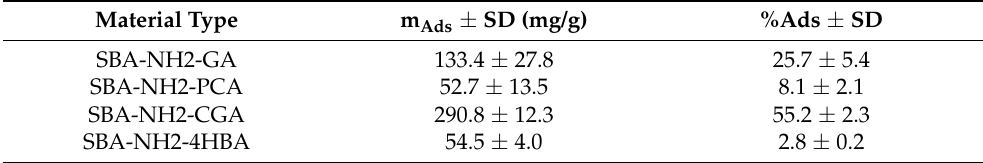
Table 2. Mean adsorption efficiency together with the amount of antioxidants adsorbed per 1 g of MSMs.